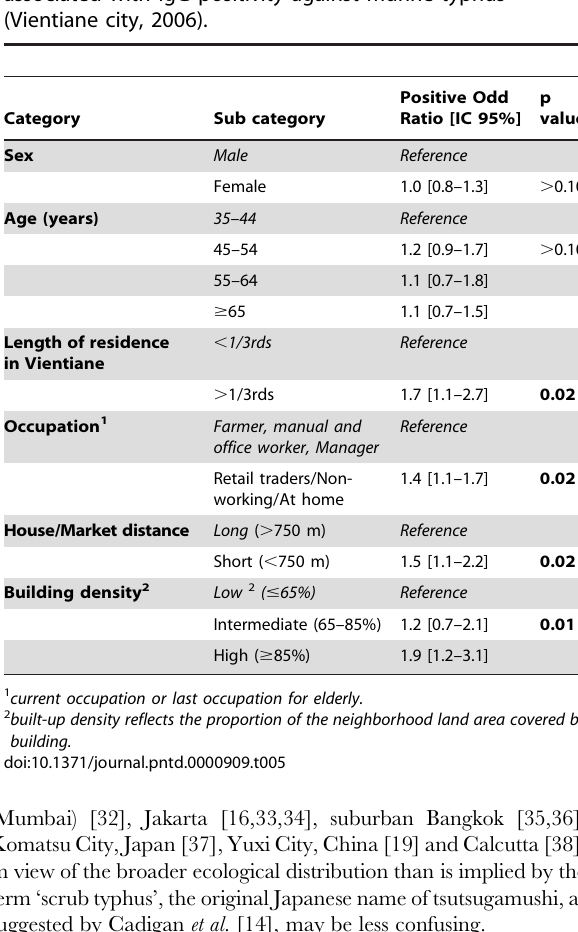
Table 5. Multivariate logistic regression analysis of factors associated with IgG positivity against murine typhus (Vientiane city,